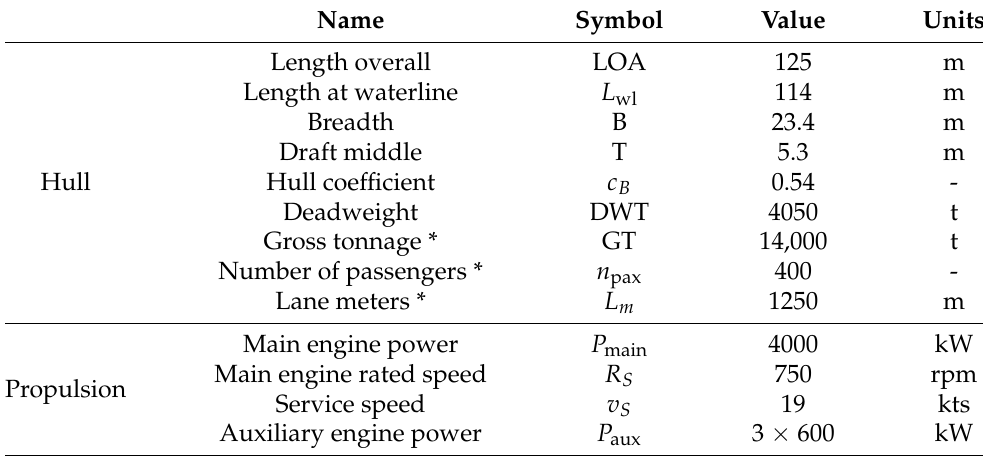
Table 3. Principal particulars and other parameters of the vessel model used by the simulator. Starred quantities are not reported by the manufacturer but correspond to values for similar